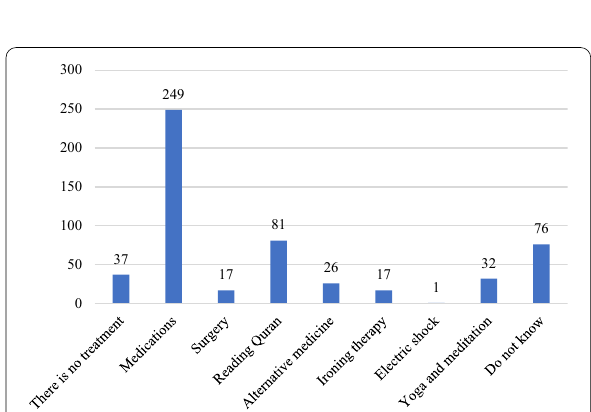
Fig. 3 Treatment or migraine control as perceived by the population of the study